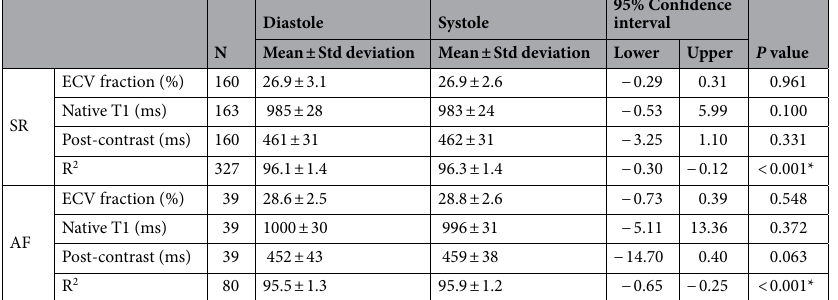
Table 3. T1 mapping in AF and sinus rhythm: differences between diastole and systole. ECV extracellular volume. P values with a * denotes statistical significance.